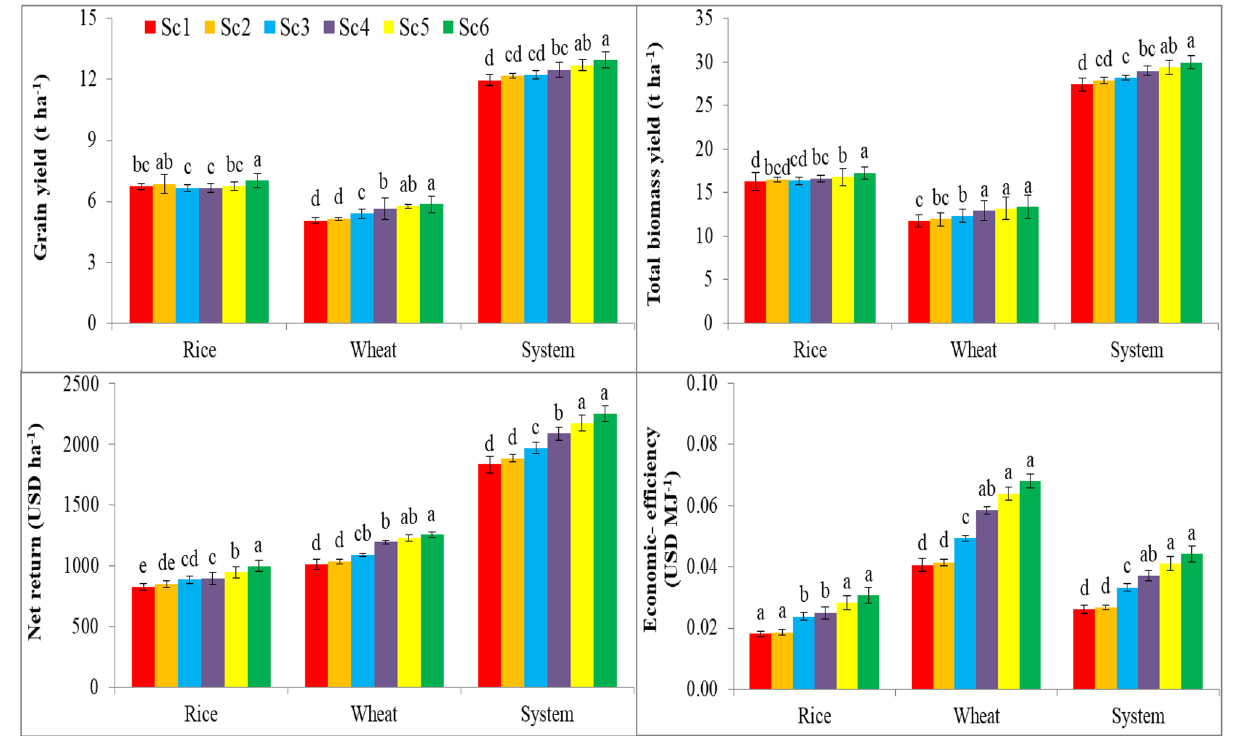
Figure 4. Effect of management practices portfolios on net return and eco-efficiency in rice, wheat and RW system (Mean of 3 years). Where; Sc1, business as usual-conventional tillage (CT) without residue; Sc2, CT with residue; Sc3, reduce tillage (RT) with residue + recommended dose of fertilizer (RDF); Sc4, RT/Zero tillage (ZT) with residue + RDF; Sc5, ZT with residue + RDF + GreenSeeker + Tensiometer; Sc6, Sc5 + Nutrient expert. Values with different lower case (a–e) letters are significantly different between each scenarios at p < 0.05 (Duncan multiple range tests for separation of mean). Vertical bars indicate ± S.E. of mean of the observed values.